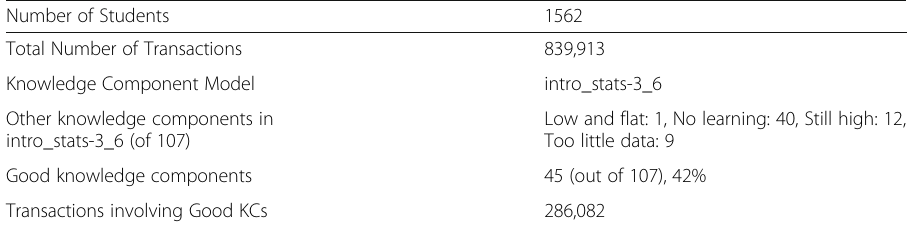
Table 1 Statistics course data summary for the 2014 course Number of